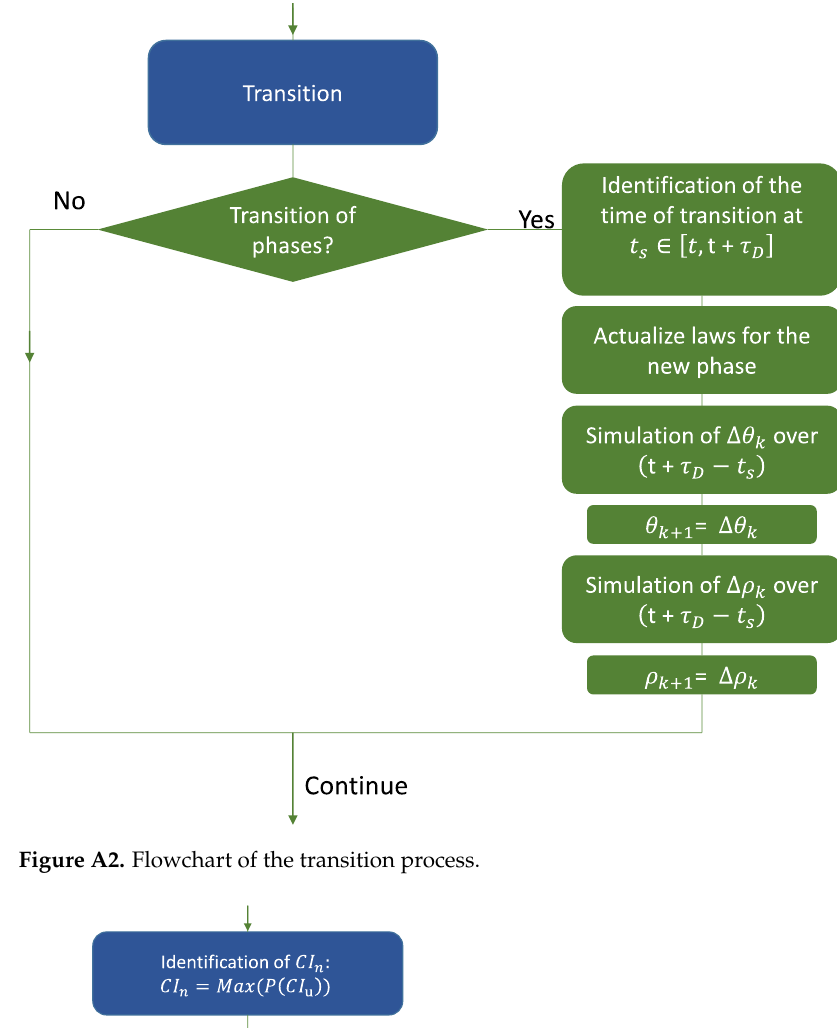
Figure A1. General flowchart of the proposed model.